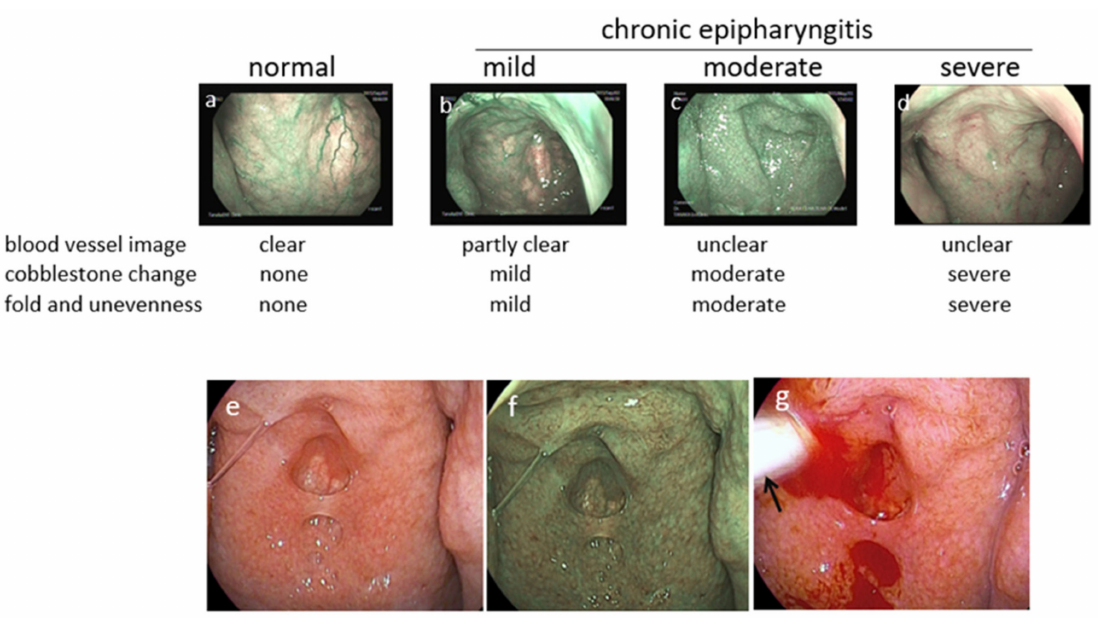
Figure 10. Endoscopic findings of chronic epipharyngitis. The vasculature is clearly visualized in the image-enhanced mode using band-limited light under normal conditions ( a ). In contrast, the vasculature is not visible due to submucosal edema and congestion, and the surface of the epipharynx becomes uneven and paved depending on the severity of chronic epipharyngitis ( b – d ). In a representative case of IgA nephropathy ( e – g ), the vasculature is obscure, and the surface exhibits a folded and cobblestone-like appearance ( e , f ). It is prone to bleeding by abrasion with a cotton